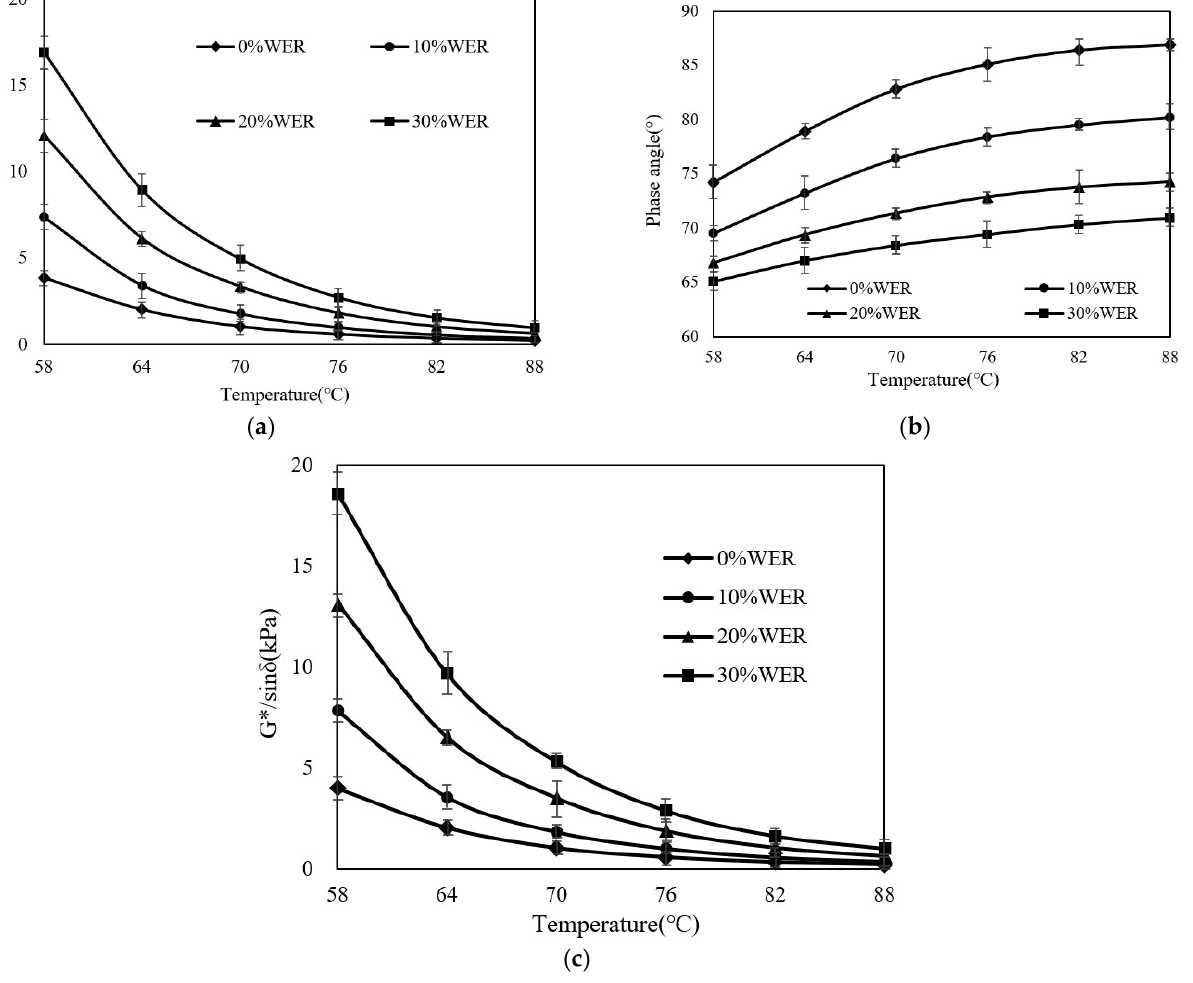
Figure 15. Results of DSR test: ( a ) complex modulus (G*); ( b ) phase angle (δ); and ( c ) G*/sinδ.